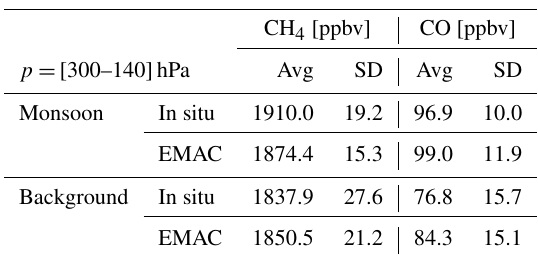
Table 1. CH 4 and CO averages and standard deviations for in situ measured and EMAC data, both for background and monsoon- influenced air masses according to the CH 4 threshold for altitudes between 300 and